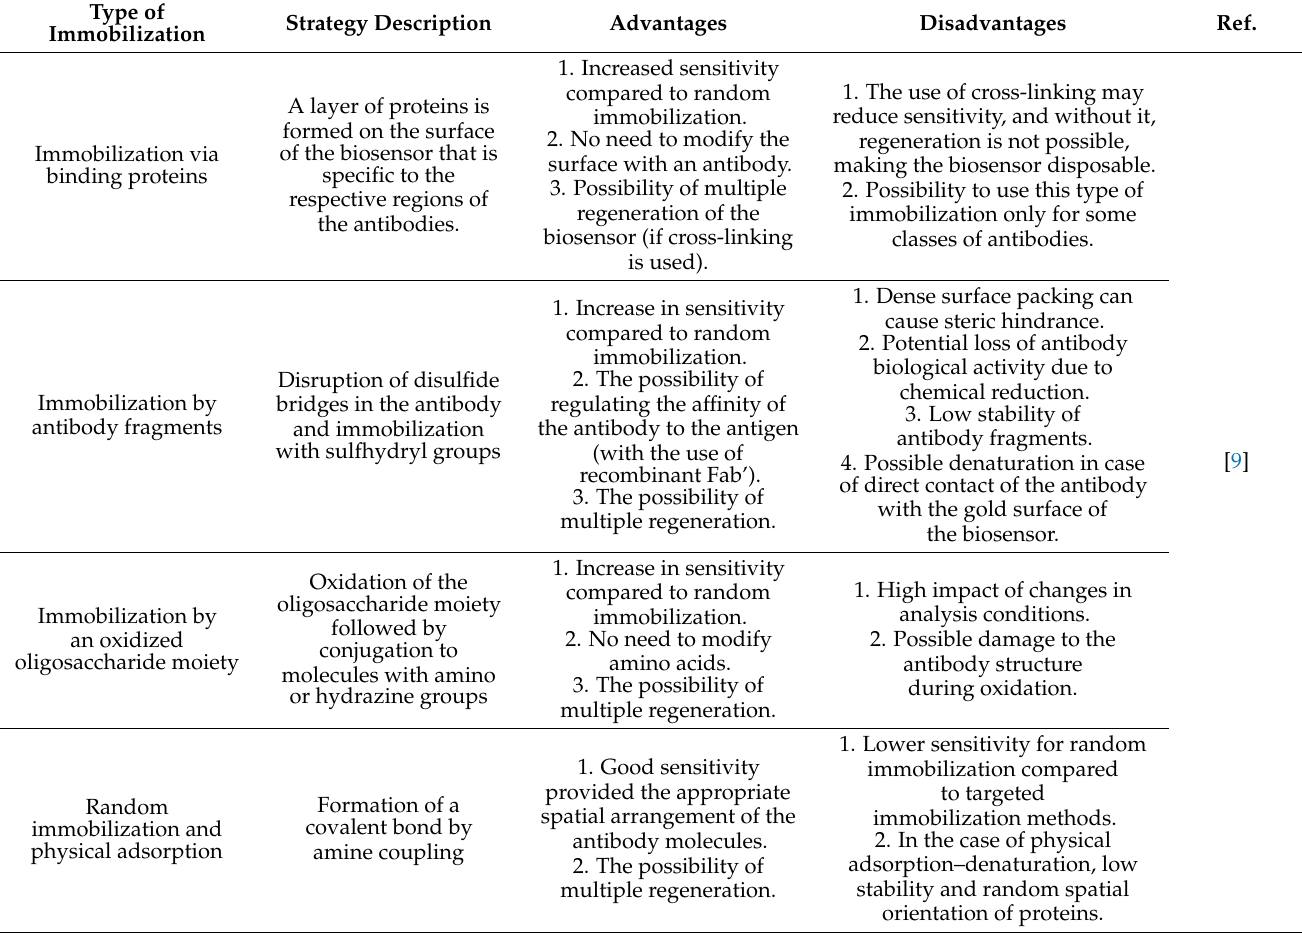
Table 1. Types of immobilizations on the biosensor